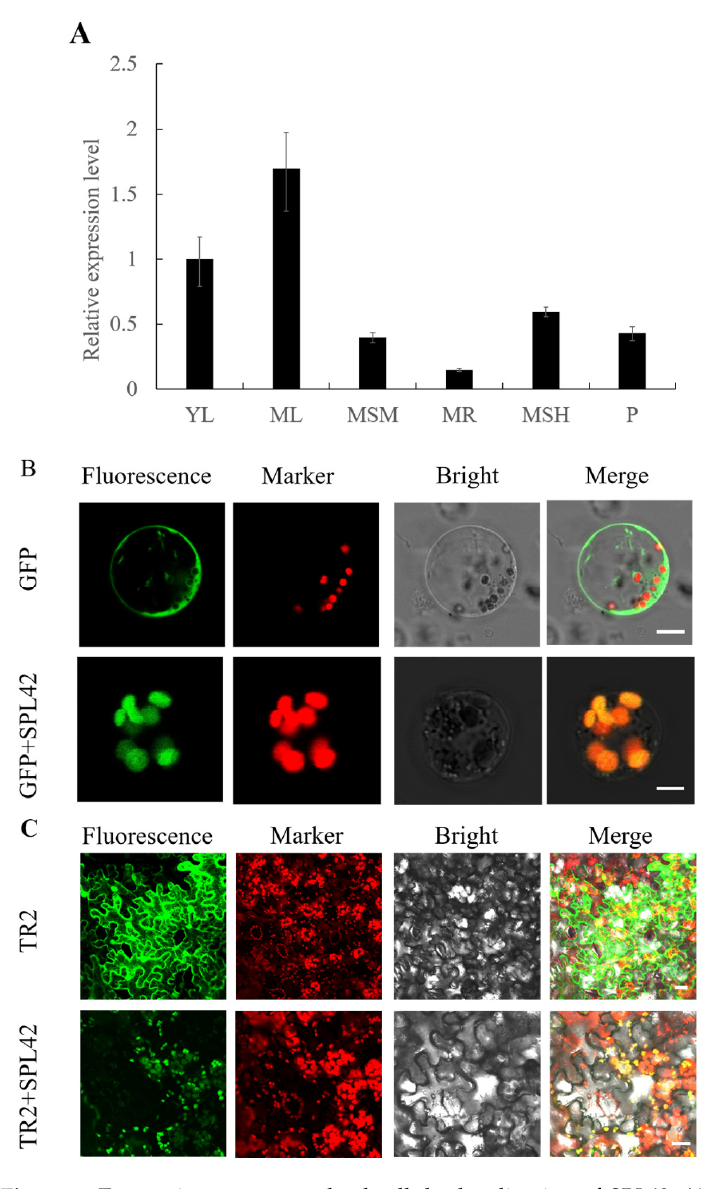
Figure 8. Expression pattern and subcellular localization of SPL42 . ( A ) Relative expression levels of SPL42 in the different tissues. YL: young leaf at the four-leaf stage; ML: mature leaf; MSM: mature stem; MR: mature root; MSH: mature sheath; P: panicle. Error bars represent + SD ( n = 3). ( B ) Subcellular localization of SPL42 in rice protoplasts. ( C ) Subcellular localization of SPL42 in tobacco leaves. TR2 indicates SPL42-GFP fusion vector was driven by an octopine type Ti-plasmid right T-DNA gene 2 (cid:48) promoter (TR 2). Signals from GFP fluorescence, chlorophyll autofluorescence, bright field, and merged images were shown. Scale Bar = 2 µ m in ( B ) and 20 µ m in ( C